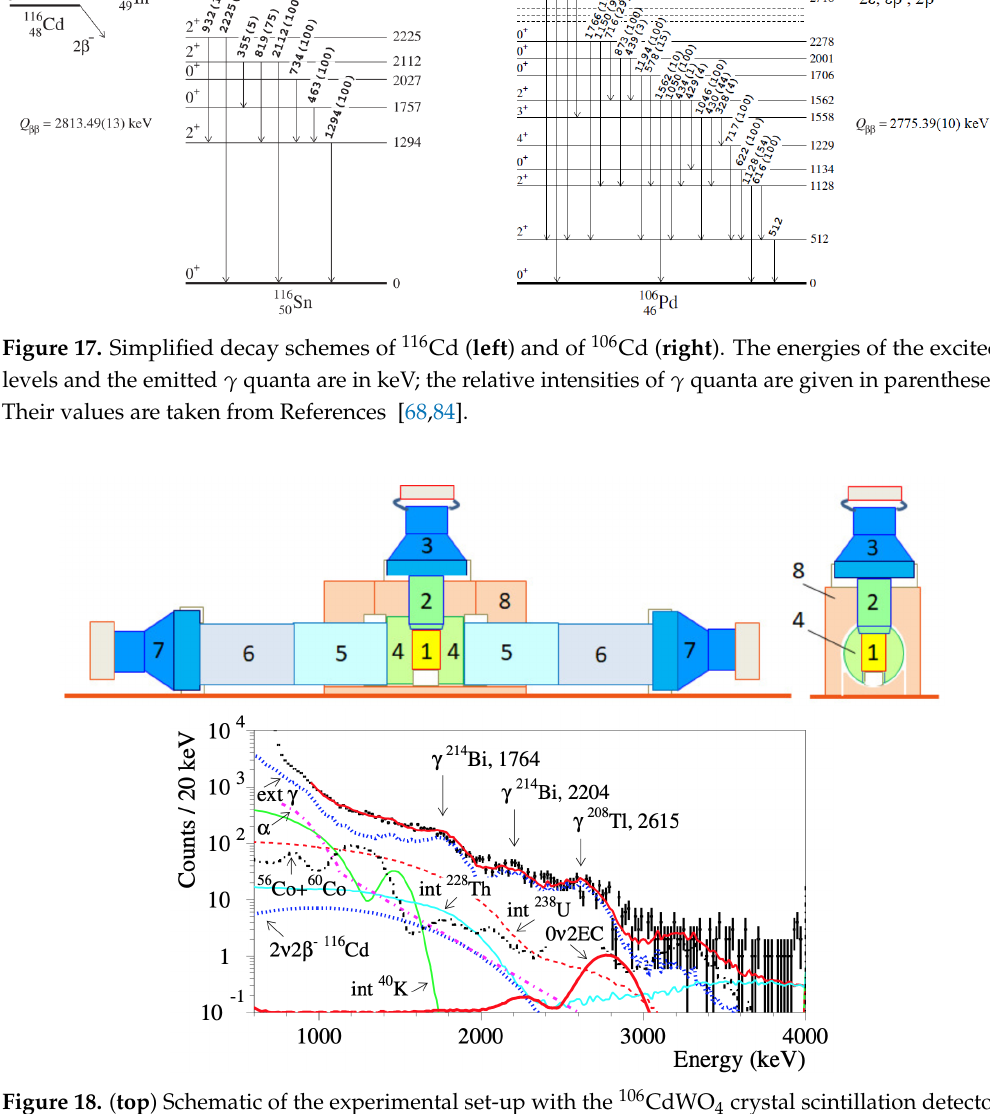
Figure 18. ( top ) Schematic of the experimental set-up with the 106 CdWO 4 crystal scintillation detector (1), viewed through PbWO 4 light-guide (2) by PMT (3). Two CdWO 4 crystal scintillators (4) are viewed through light-guides glued from quartz (5) and polystyrene (6) by PMTs (7). The detector system was shielded by copper, lead, cadmium, and polyethylene (not shown). Only part of the copper details (8) is shown [84]. ( bottom ) Energy spectrum of the γ ( β ) events accumulated for 26.033 h by the 106 CdWO 4 scintillation detector in anti-coincidence with the CdWO 4 counters together with the background model (red line). The excluded distribution of the 0 ν 2 ε decay of 106 Cd to the ground state of 106 Pd with the half-life T 1/2 = 6.8 × 10 20 yr is shown by red solid line [84]. Figures reprinted from Reference